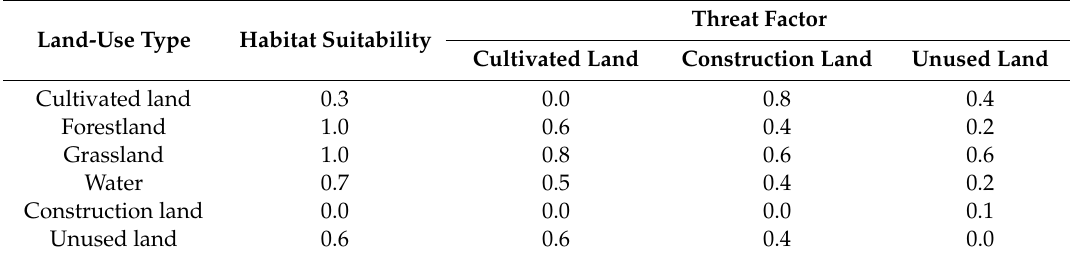
Table 4. Sensitivity of each land-use type to habitat threat